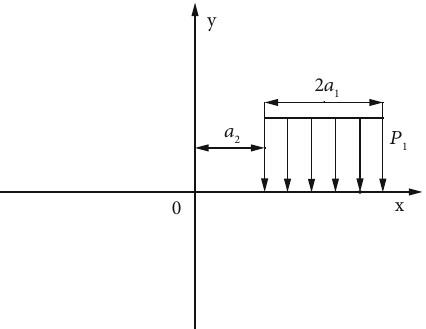
Figure 5: Basic mechanical constitutive model along the empty lane.